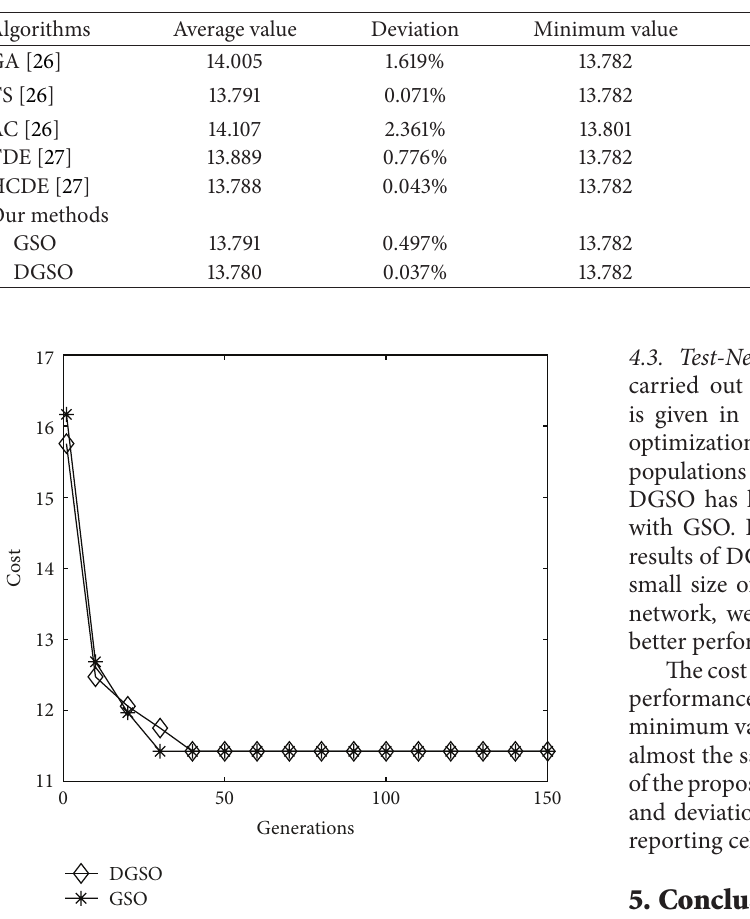
Table 6: Results for the 8 × 8 network.